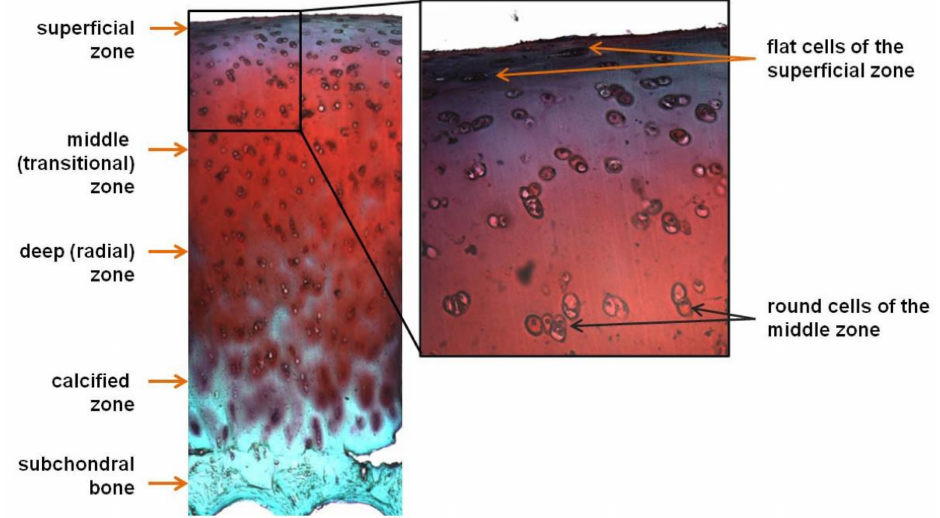
Figure 2. Histology images showing the structure of the different zones within a cross-section of adult human articular cartilage, stained with Safranin-O and Fast Green, and the corresponding morphologies of chondrocytes within the tissue. Reproduced under the terms of a Creative Commons Attribution License from [39]. © 2021 The Authors. Published by